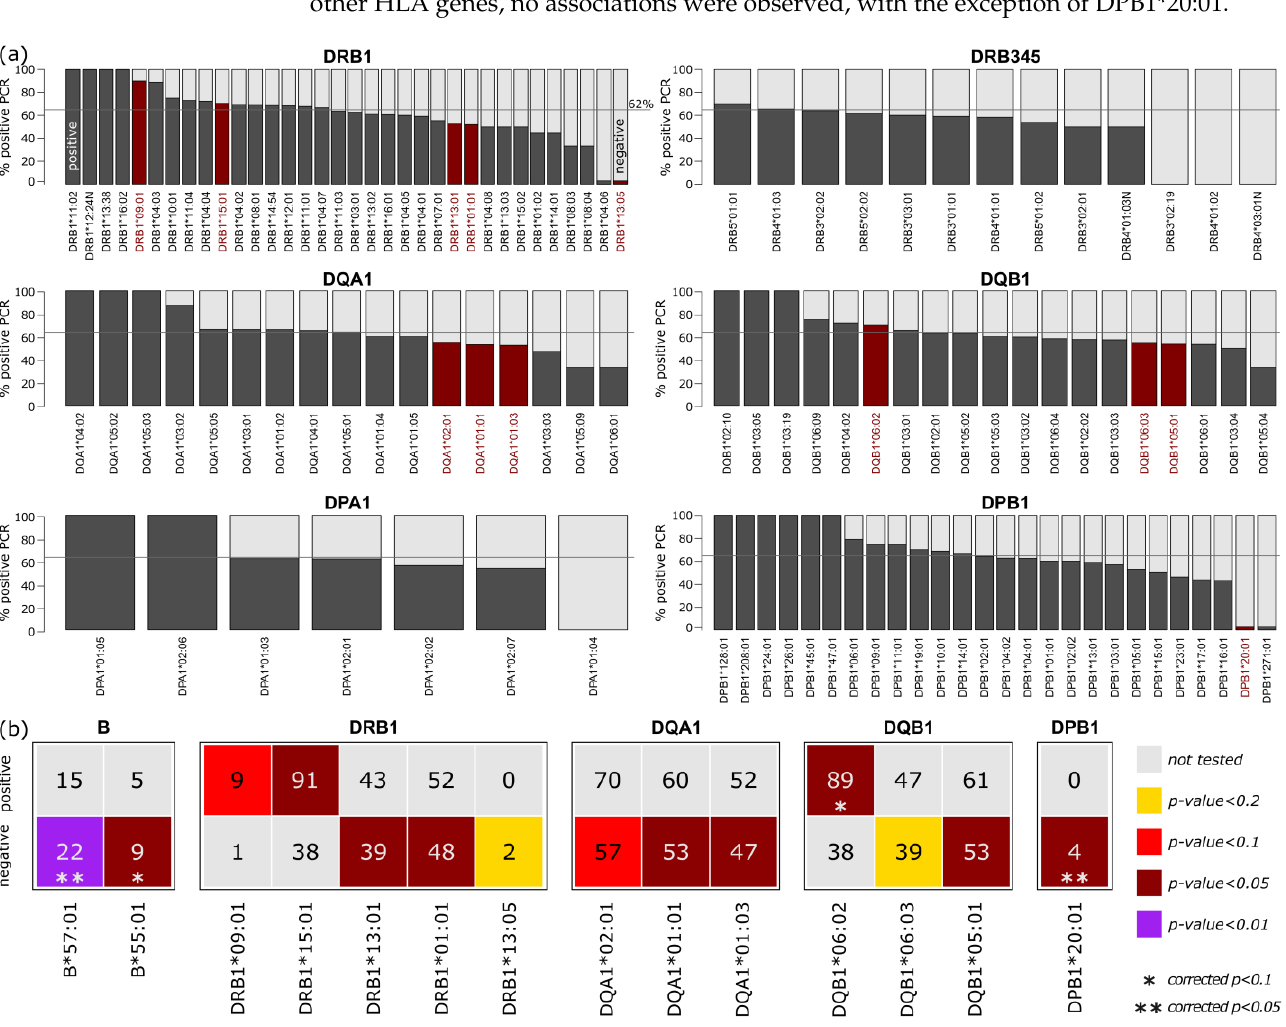
Figure 3. Analysis of the class II alleles with regard to PCR status: ( a ) Percent of persons with positive PCR stratified by the alleles of DRB1, DRB345, DQA1, DQB1, DPA1, and DPB1 loci. Alleles with corrected p -values < 0.05 are highlighted in red (see description of Figure 2). T-statistics of the loci are given as Figure S4 in the supplementary text. ( b ) Contingency tables of the selected HLA class I and II alleles (corrected p -value < 0.05). Numbers refer to all persons with the respective allele, split by positive and negative PCR status. Colors indicate significance of enrichment as obtained from Fisher’s exact test (see figure legend). Enrichments with p -values < 0.1/0.05 after Bonferroni correction are highlighted with asterisks.